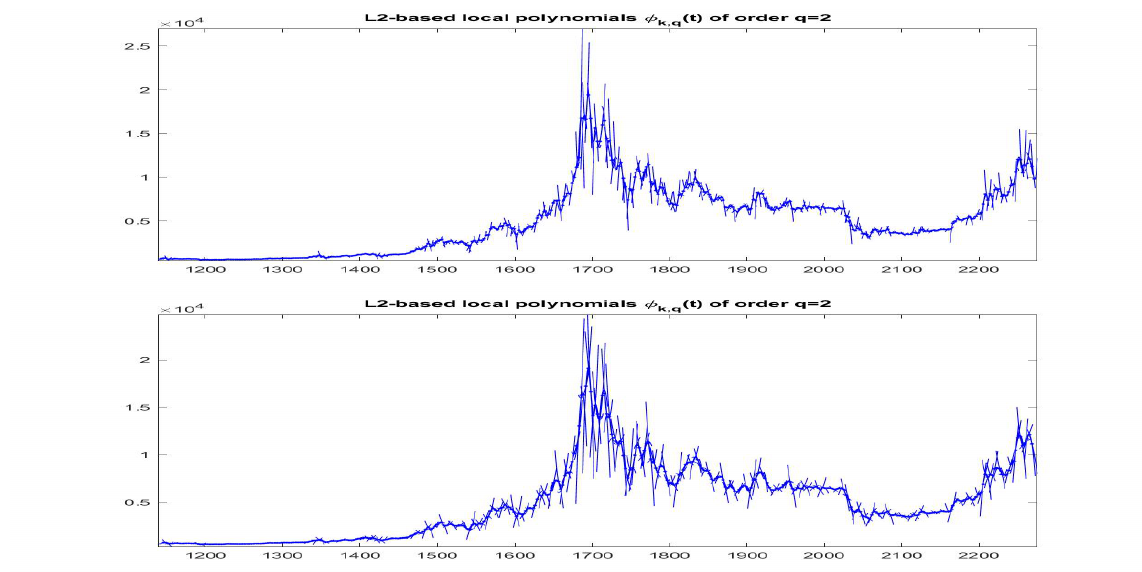
Figure 16. L 2 -norm F-transform components of order 2 for Bitcoin series. The fuzzy r -partition is P a with r = 4 ( top picture) and r = 7 ( bottom